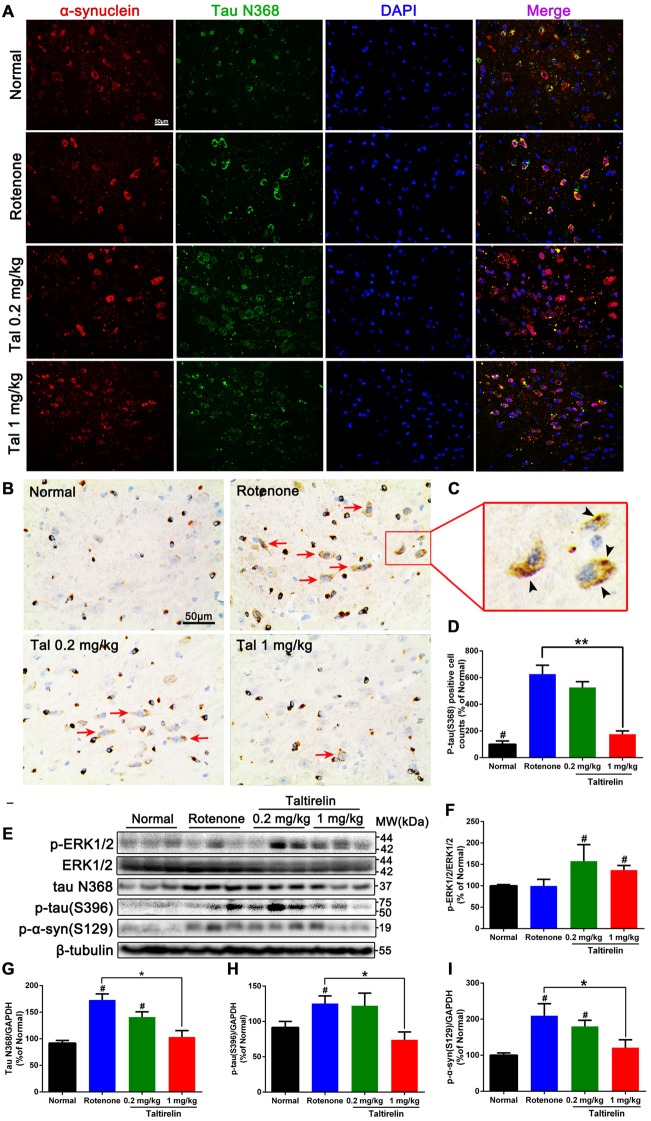
Taltirelin down-regulated tau and α-synuclein-related pathology in rotenone-induced PD model mice. (A) Double-labeled immunofluorescence images showed co-localization of α-synuclein and tau N368 in the SN of each group (normal, rotenone, 0.2 or 1 mg/kg Taltirelin). (B) Immunostaining of p-tau (S396) in the SN. Red arrows indicated the positive cells. (C) The enlarged graph of indicated field. Black arrowheads indicated intracellular p-tau (S396) aggregation. (D) Analysis of p-tau (S396) positive cells counts in each group. (E) Western blot analysis of p-ERK1/2, tau N368, p-tau (S396) and p-α-synuclein (S129) in the SN of each group. (F–I) Quantification of WB showed the levels of p-ERK1/2, tau N368, p-tau (S396) and p-α-synuclein (S129). #p < 0.05 vs. other groups; *p < 0.05; **p < 0.01. N = 3. Error bars represent SEM.